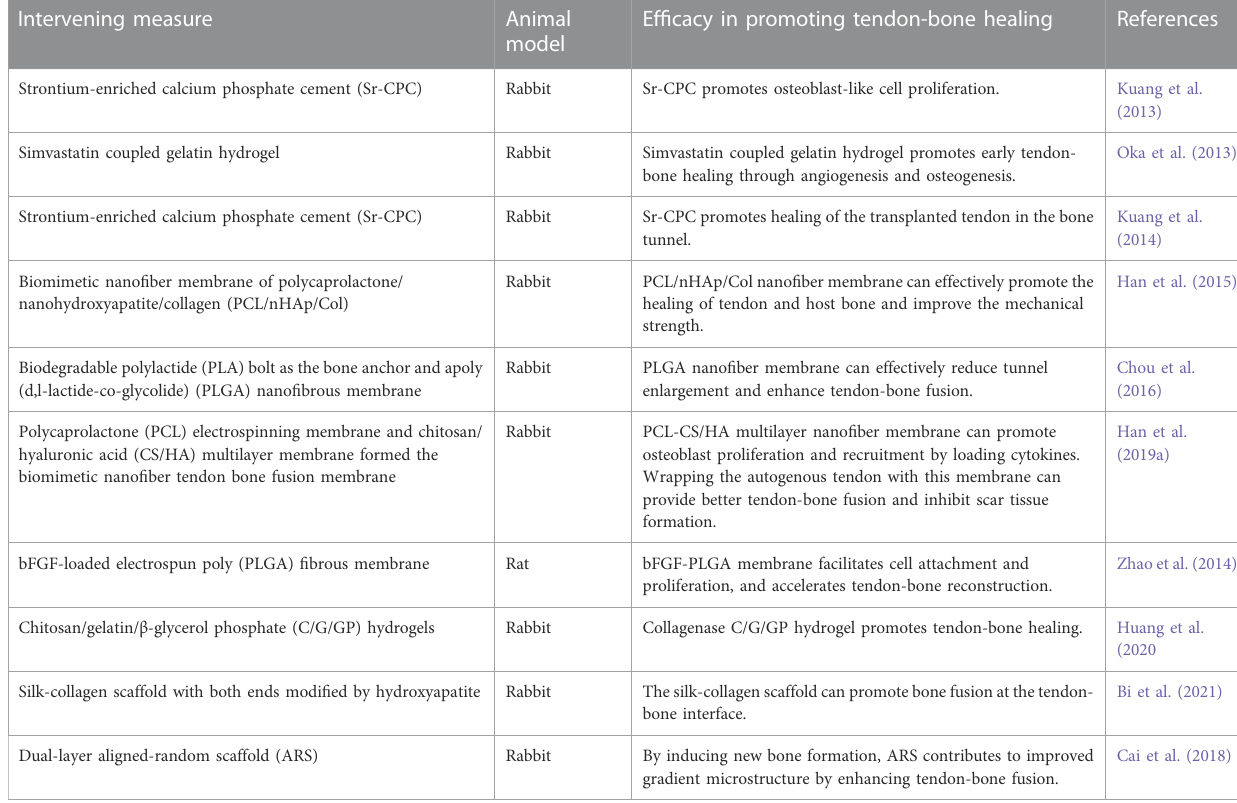
TABLE 2 Preclinical studies of biomaterials promoting tendon-bone healing in ACL reconstruction. Intervening